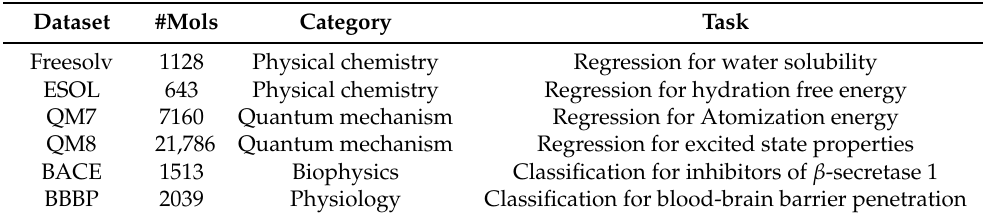
Table 1. Summary of the dataset used in the experiments.